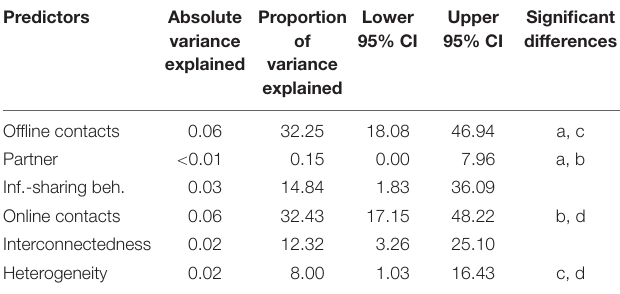
TABLE 3 | Regression results for social loneliness as the criterion. Predictor